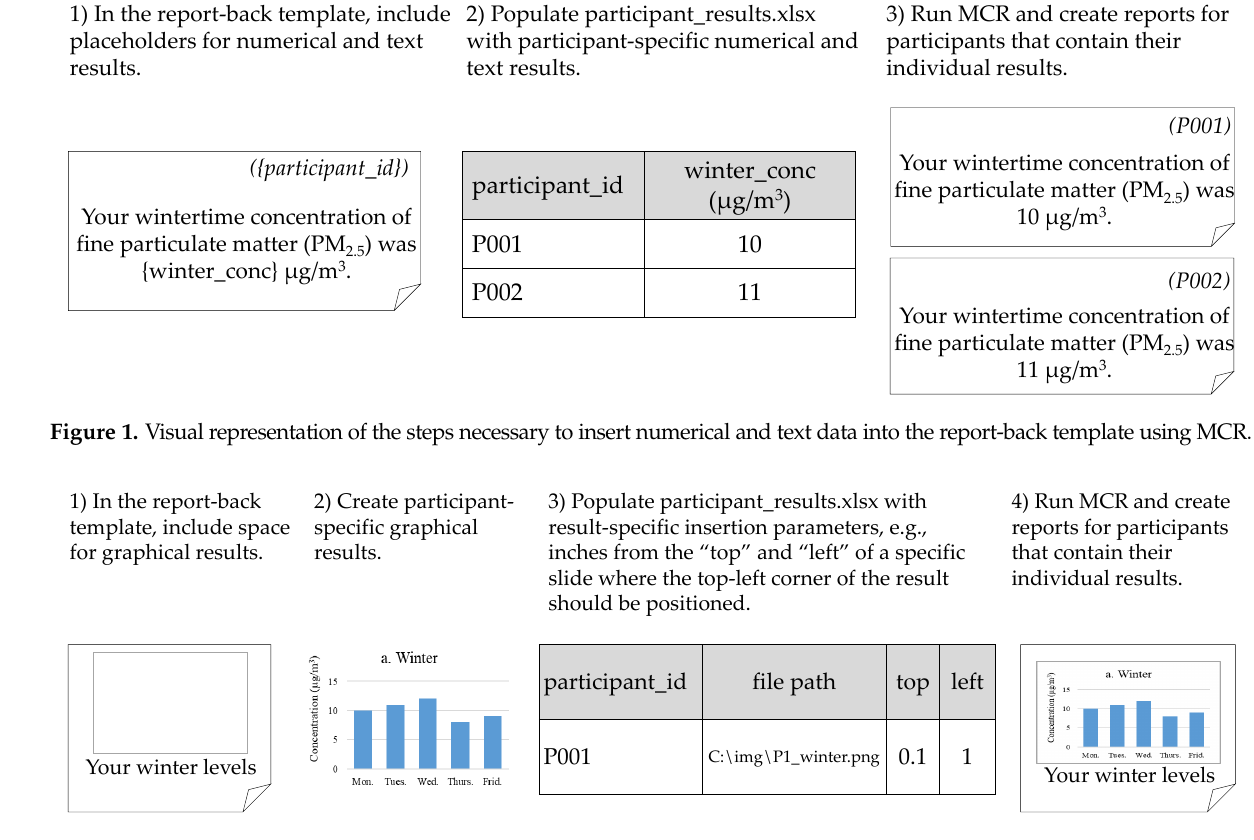
Figure 2. Visual representation of the steps necessary to insert graphical results into the report-back template using